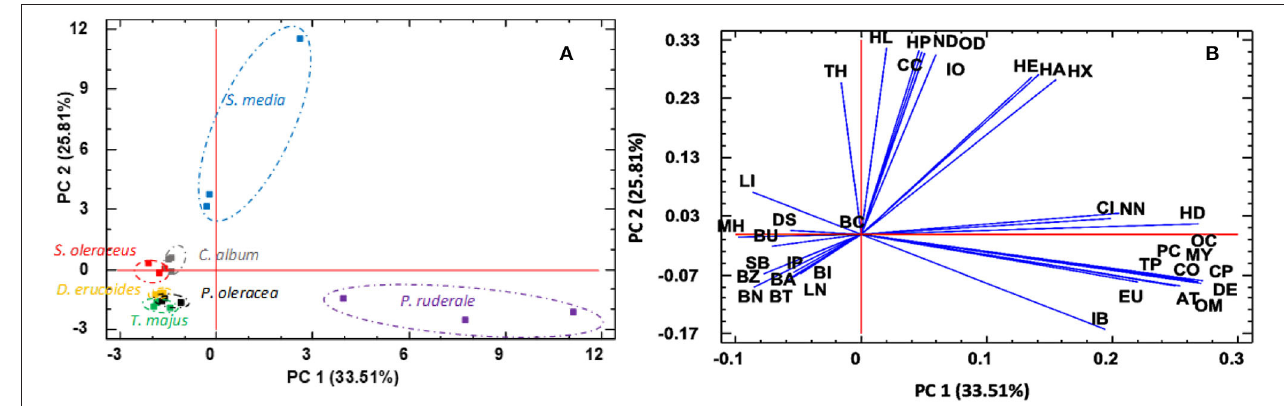
FIGURE 3 | Principal component analysis (PCA) of the investigated samples. Scores (A) and loadings (B) of the two principal components on the matrix correlations were built using data from individual volatiles.